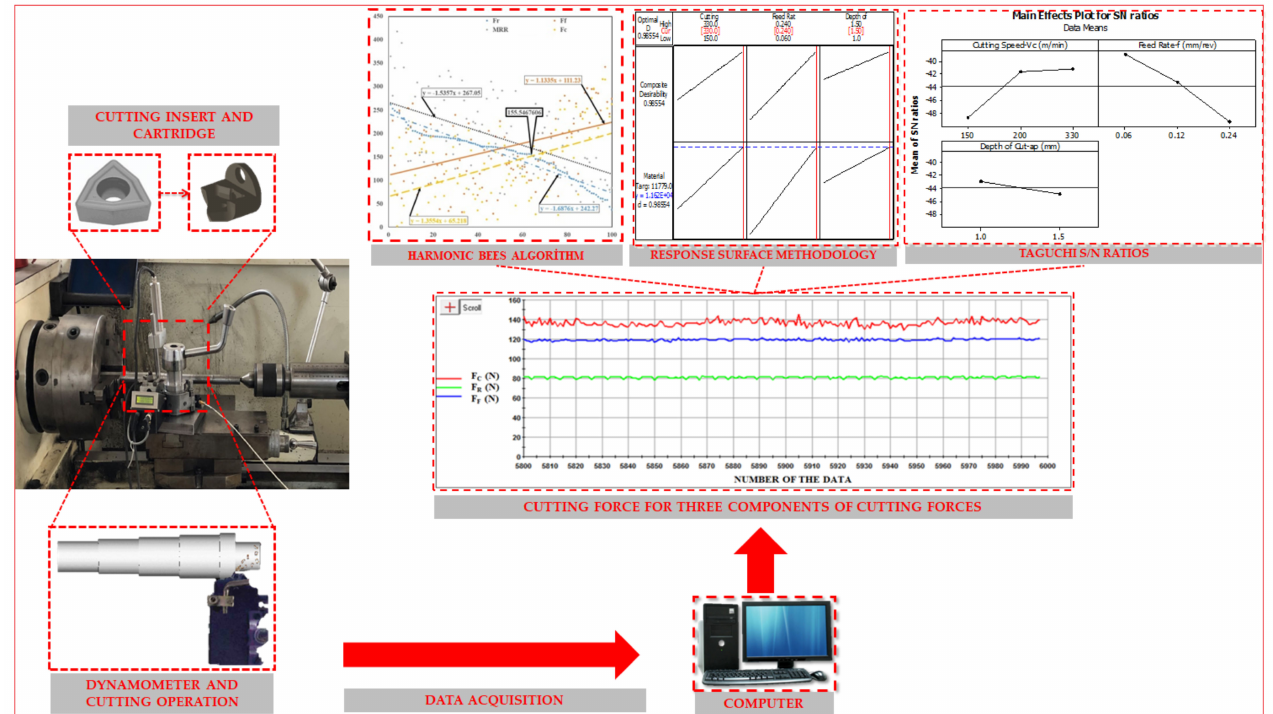
Figure 2. Experimental details